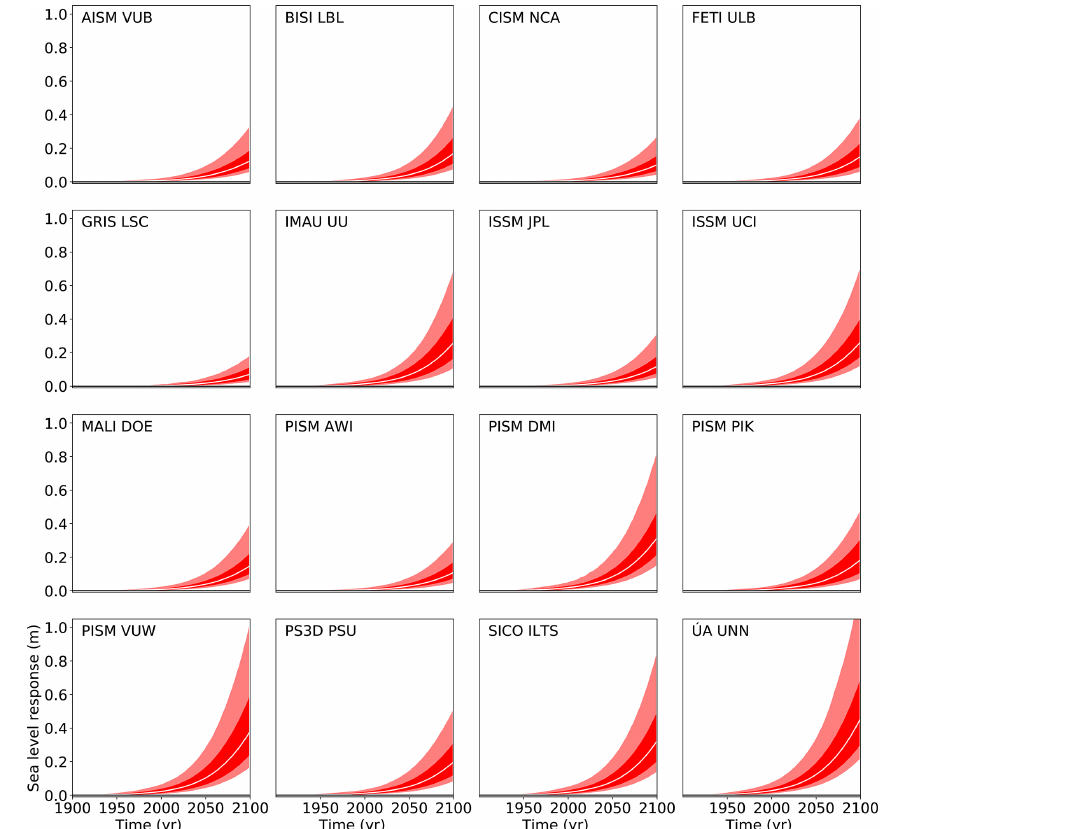
Figure 9. Projection of Antarctica’s sea level contribution under the RCP8.5 carbon concentration scenario following the procedure depicted in Fig. 1 and detailed in Sect. 2. The white line represents the median value, the dark shading the likely range (66th percentile around the median), and the light shading the very likely range (90th percentile around the median). Compare Tables 7–10 for the values and their comparison to the other